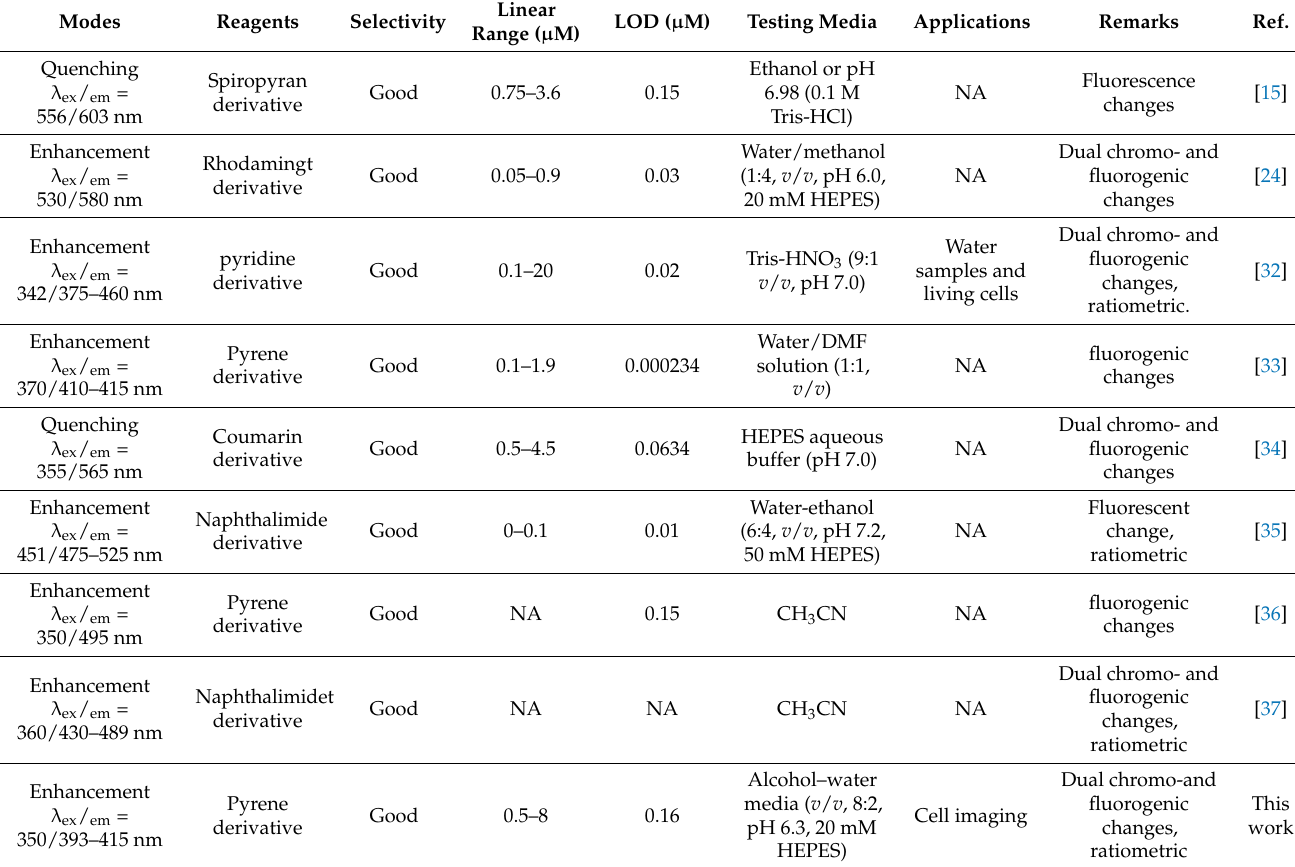
Table 1. Performances comparison of various fluorescent probes for Cu 2+